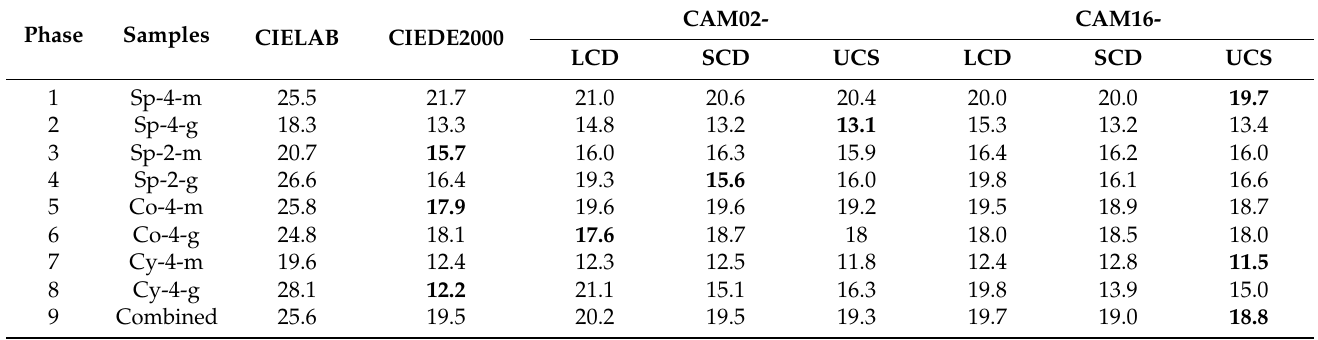
Table 10. STRESS values [25] achieved by the eight color-difference formulas based on the values of k L and b shown in Table 9. The numbers in bold indicate the best color-difference formula for each phase.